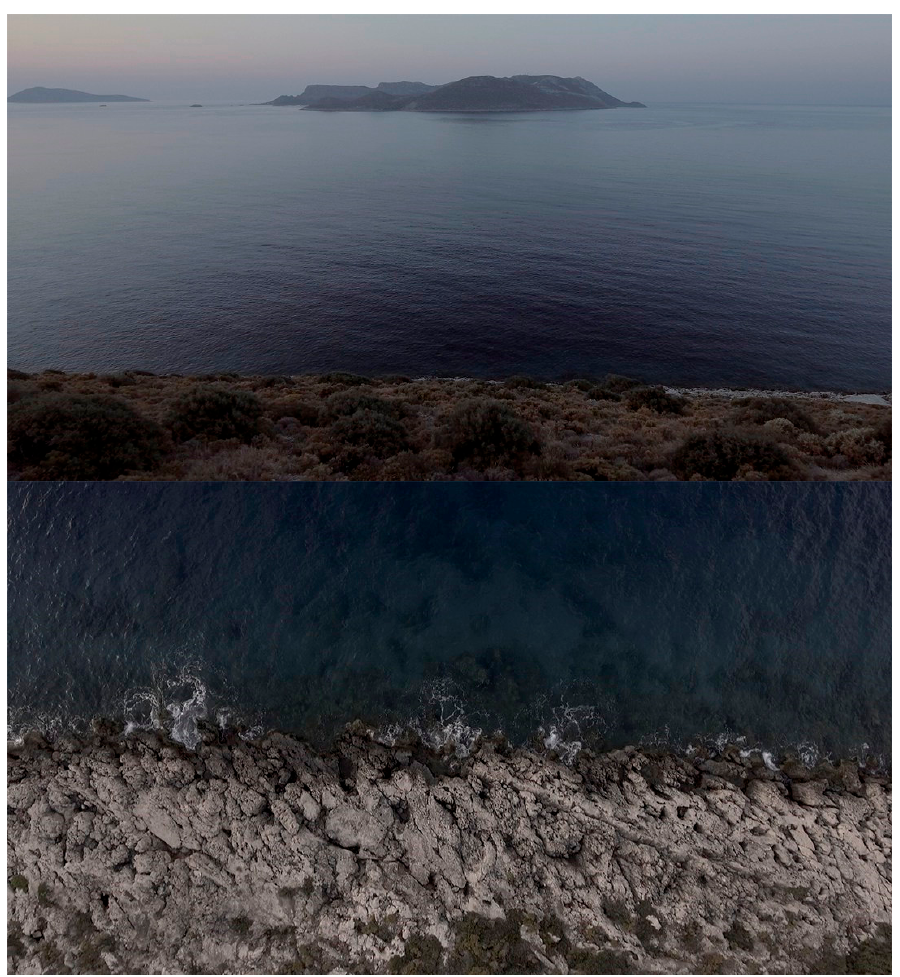
Figure 11. From Hrair’s ‘Horizon’ (2016). (Two channel video, HD.) Used by permission of the artist.